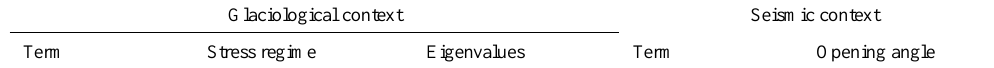
Table 1. The different ice crystal distributions as used for the calculation of seismic velocities and reflection coefficients. Given are the sketches for the enveloping of the c-axis distribution, the glaciological terms, the common stress regime and the corresponding eigenvalue range. In the second part the seismic term for the anisotropic regime is given together with the opening angles derived from the COF eigenvalues to calculate the elasticity tensor.